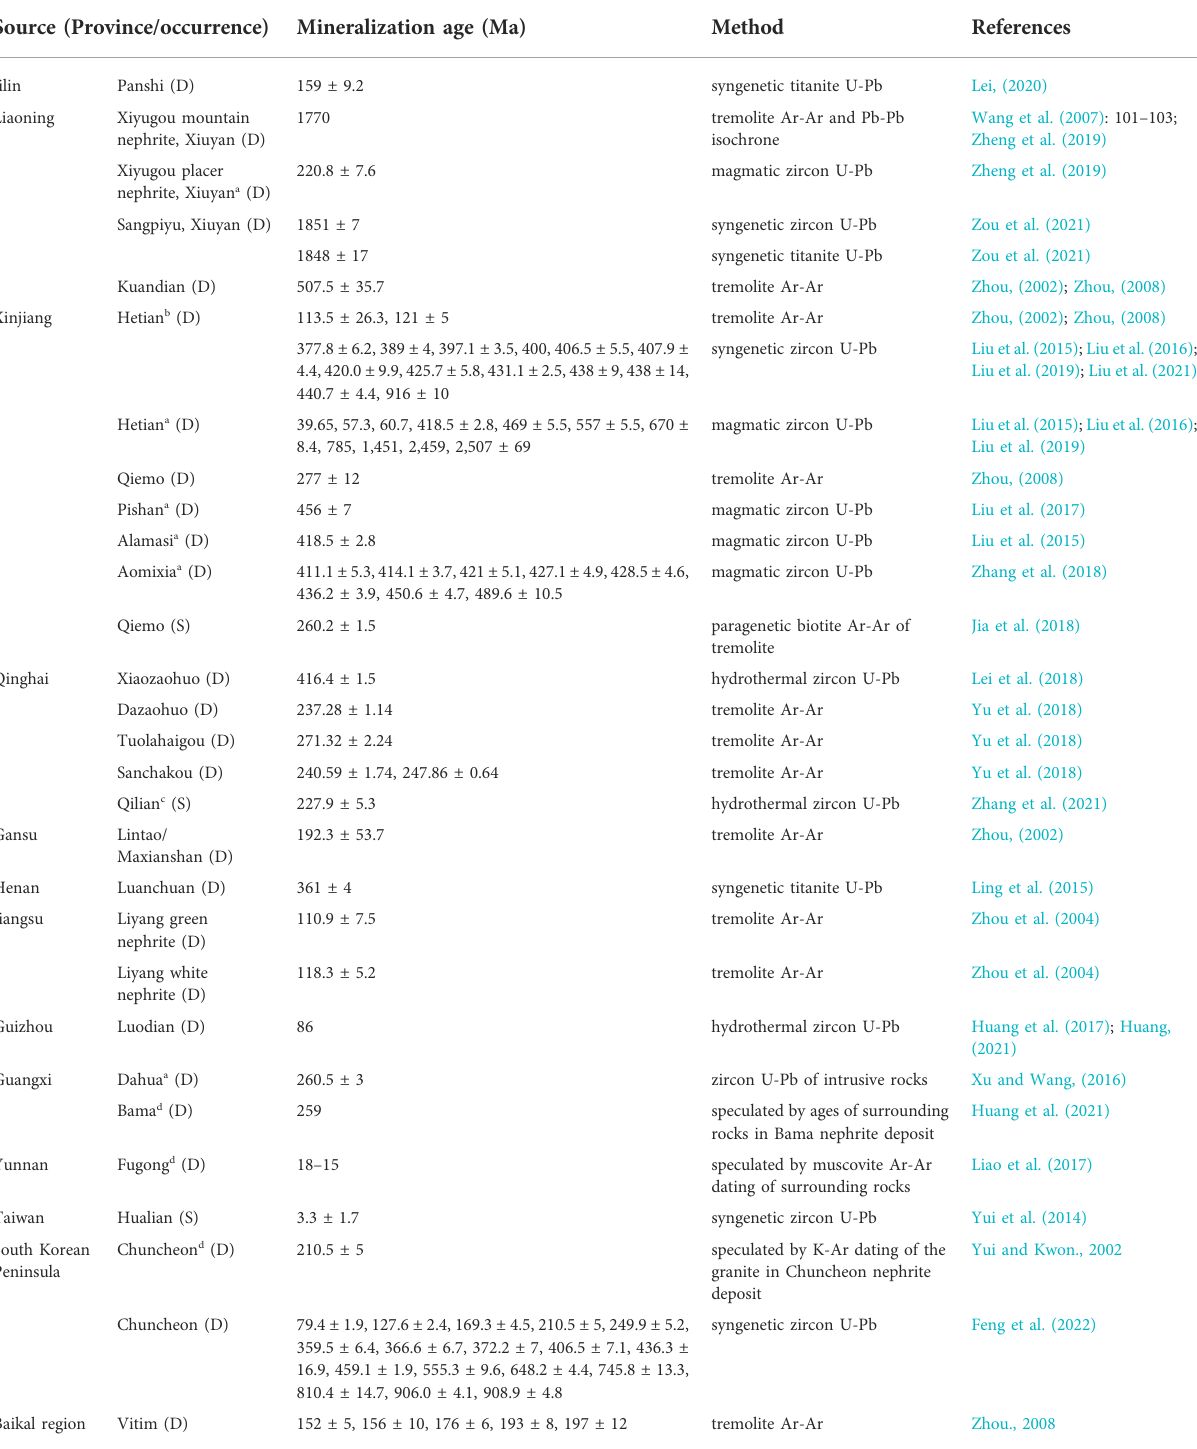
TABLE 1 Radioisotope dating of modern nephrite